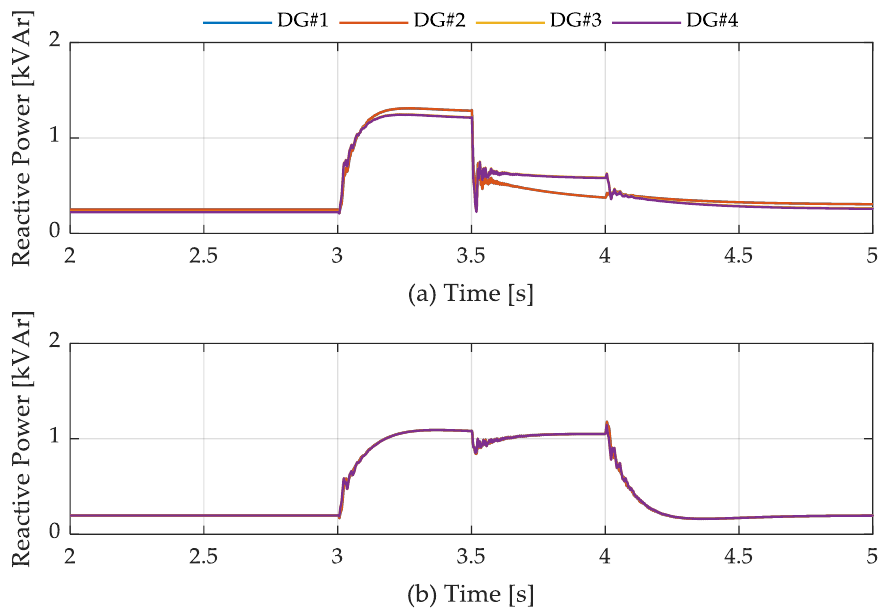
Figure 16. Output reactive power of each DG: ( a ) centralized method; ( b ) proposed method.